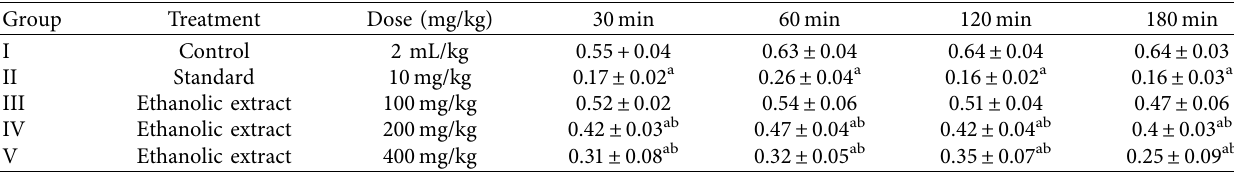
Table 7: Efect of ethanolic extract of Artocarpus hirsutus Lam on carrageenan induced rat paw edema method. Group